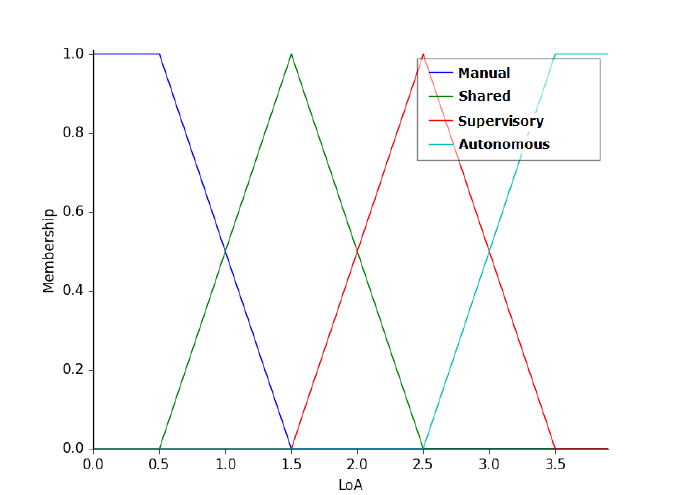
Figure 10. Membership functions of the variable LoA—i.e., level of